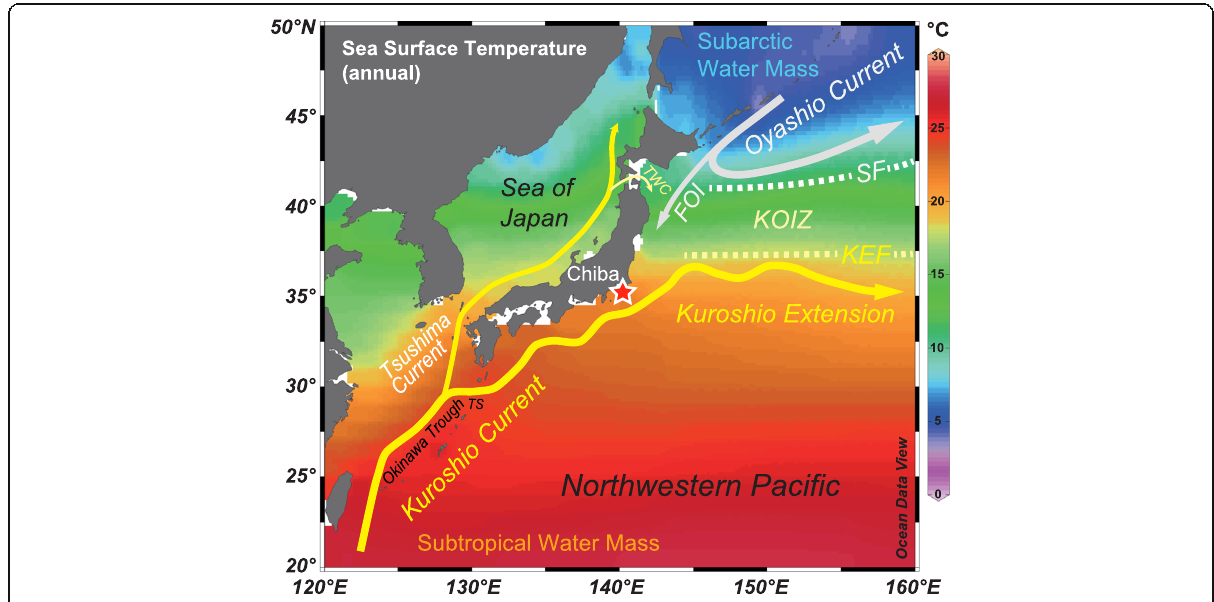
Fig. 15 Present oceanography of the northwestern Pacific Ocean, showing annual sea-surface temperature from the World Ocean Atlas 2013 (Locarnini et al. 2013) drawn using Ocean Data View software (Schlitzer 2015). Major oceanographic features are included. TWC = Tsugaru Warm Current. SF = Subarctic Front formed by the Subarctic Current, an eastward extension of the Oyashio Current. KEF = Kuroshio Extension Front. KOIZ = Kuroshio – Oyashio interfrontal zone, a zone of mixing between the SF and KEF. TS = Tokara Strait. FOI = first Oyashio intrusion. Adapted from fig. 1 of Suganuma et al.